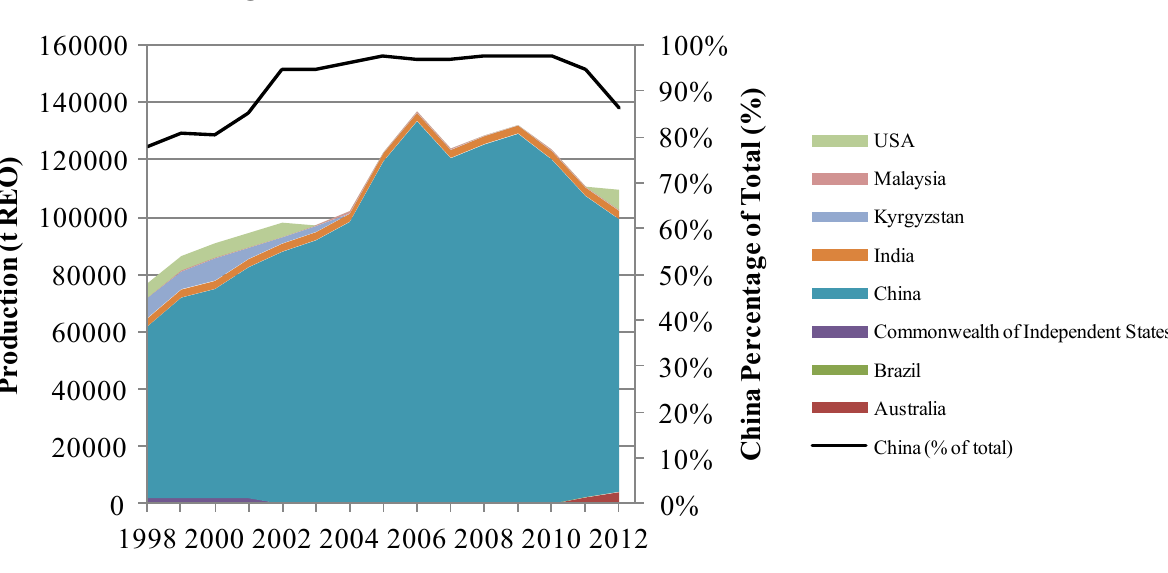
Figure 1. Production trends in rare earths—data source